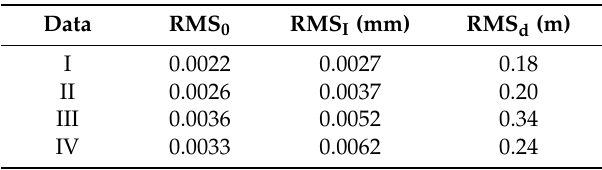
Table 2. Results of the unit weighted RMS of the registration.